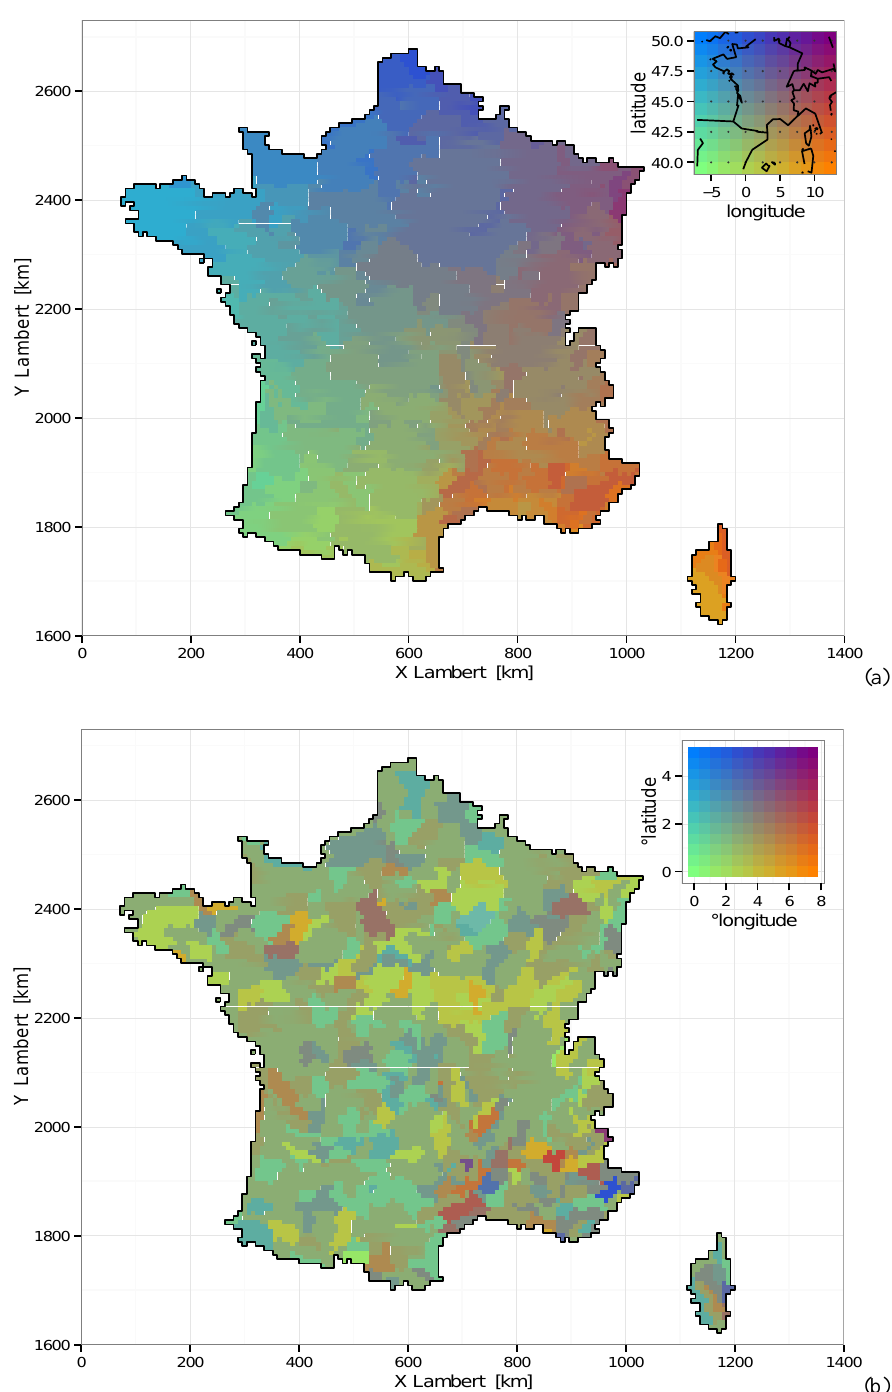
Fig. 6. (a) Mean domain centre of the five best domains found during the domain optimisation. The colours correspond to the mean location of the domain centres of the five best domains for each target zone. (b) Maximum difference in domain centre location between two domains in the five-best-domain ensemble. The colours correspond to the maximum distance of centre points in degrees longitude and latitude. Green, the centres are very close to each other; purple, the centres are very far from each other; blue, the centres are close in longitude but comparatively far in latitude direction; and orange, far in longitude and close in latitude